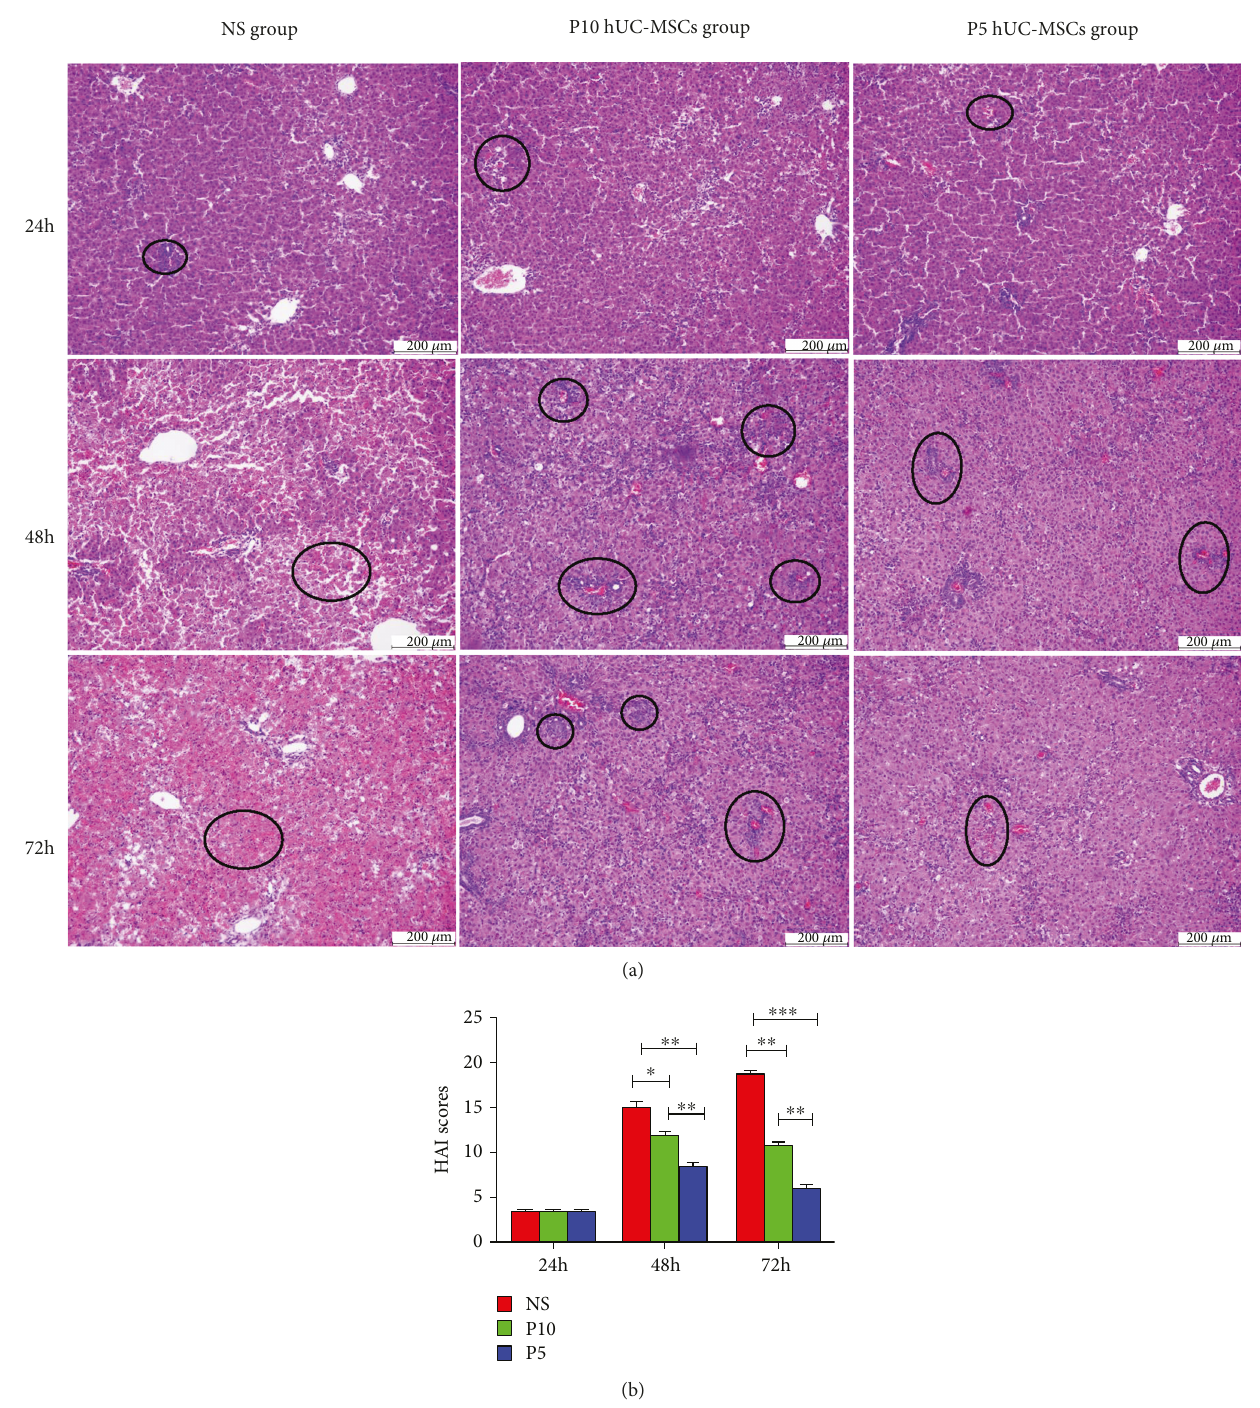
Figure 3: Histopathological recovery of D-GaIN/LPS-induced ALF transplanted with hUCMSCs at 24 h, 48 h, and 72 h. (a) H&E staining showed that there were massive necrosis and hepatic lobule damage in the NS group. In contrast, hepatocyte necrosis was suppressed in both P5 hUC-MSCs group and P10 hUC-MSCs group after transplantation. hUC-MSCs treatment also reduces the number of in fl ammatory in fi ltration. The black circles represent the hepatocyte necrosis and severe in fl ammatory cell in fi ltration. Bar=200 μ m. (b) Histopathological grading of necrosis and in fl ammation of the liver sections. Data are presented as mean ± SD. ∗ P < 0 05 , ∗∗ P < 0 01 , ∗∗∗ P < 0 001 . D-GalN, D-galactosamine; HAI, hepatic activity index; IP, intraperitoneal; LPS, lipopolysaccharide; NS, normal e ff ectiveness of hUC-MSC transplantation. Histological evaluation of the liver tissue after cell administration